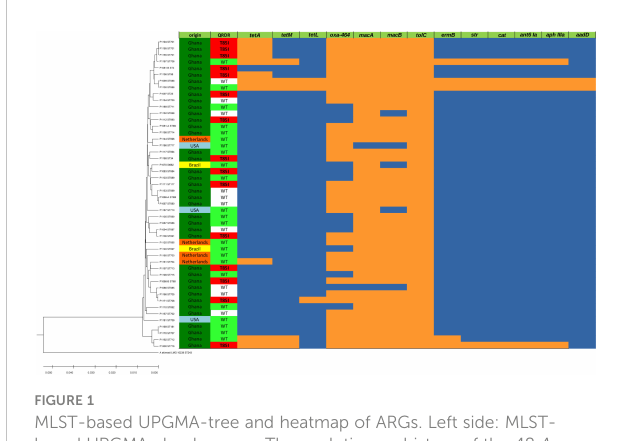
FIGURE 1 MLST-based UPGMA-tree and heatmap of ARGs. Left side: MLST- based UPGMA-dendrogram: The evolutionary history of the 48 A. butzleri isolates was inferred using the UPGMA method. For reference A. skirrowii LMG 10238 was included as outgroup in our analysis. The depicted optimal tree is drawn to scale and has a sum of branch length of 0.27052614, with branch lengths in the same units as those of the evolutionary distances used to infer the phylogenetic tree. Right side: Legend/Color codes: origin: green – Ghana, orange – The Netherlands, light blue – USA, yellow – Brazil; QRDR (quinolone resistance determining region): red – T85I amino acid substitution in the QRDR associated with cipro fl oxacin resistance (inhibition zone diameter < 13 mm), green – wild type (WT) QRDR and phenotypic cipro fl oxacin susceptible isolate (inhibition zone diameter > 19 mm), white – wild type (WT) QRDR but phenotypic cipro fl oxacin resistant (< 13 mm) isolate; ARGs (see also Table 1): orange – positive PCR result, blue – negative PCR